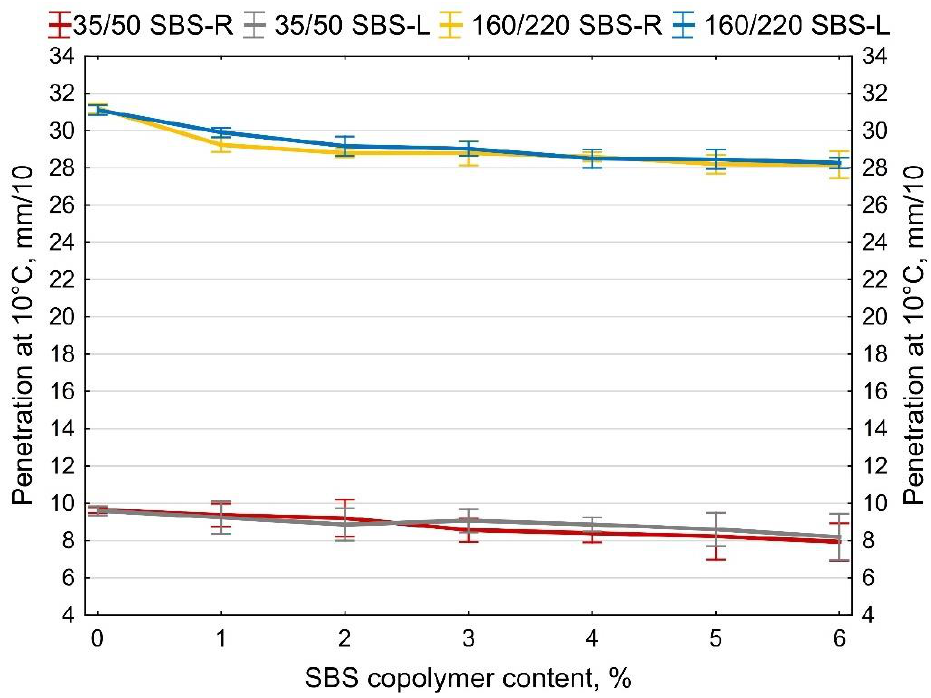
Figure 9. Penetration at 10 °C of SBS-modified bitumens, error bars show a 95% confidence interval for the mean.